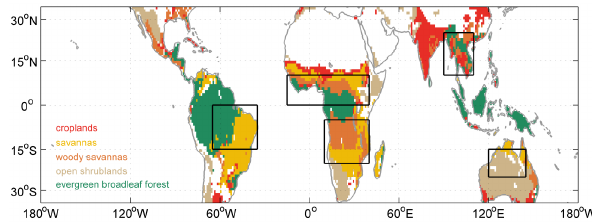
Figure 9. Global land cover map used for the distinction of the different biomes (see also Sect. 2.3 and Table 2). The selected land cover types are evergreen broadleaf forest (green), open shrublands (beige), woody savannas (orange), savannas (yellow), and croplands (red).